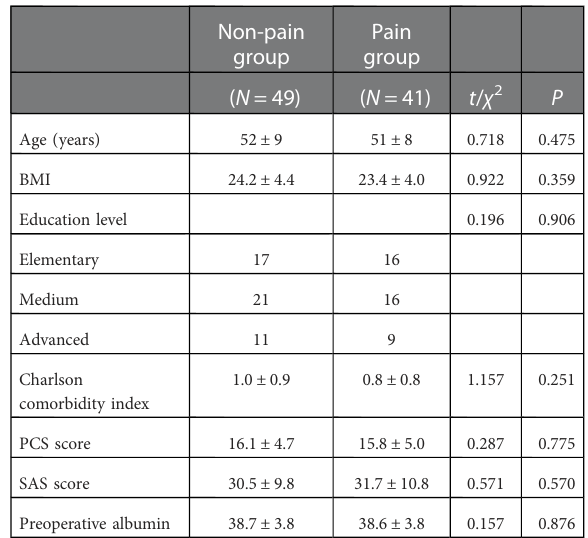
TABLE 7 Baseline levels were compared between the two